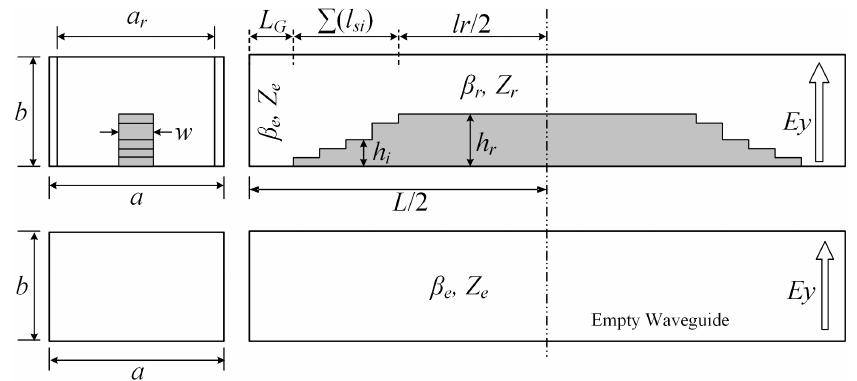
Figure 2. Scheme of the DPS with physical and electrical parameters definition.